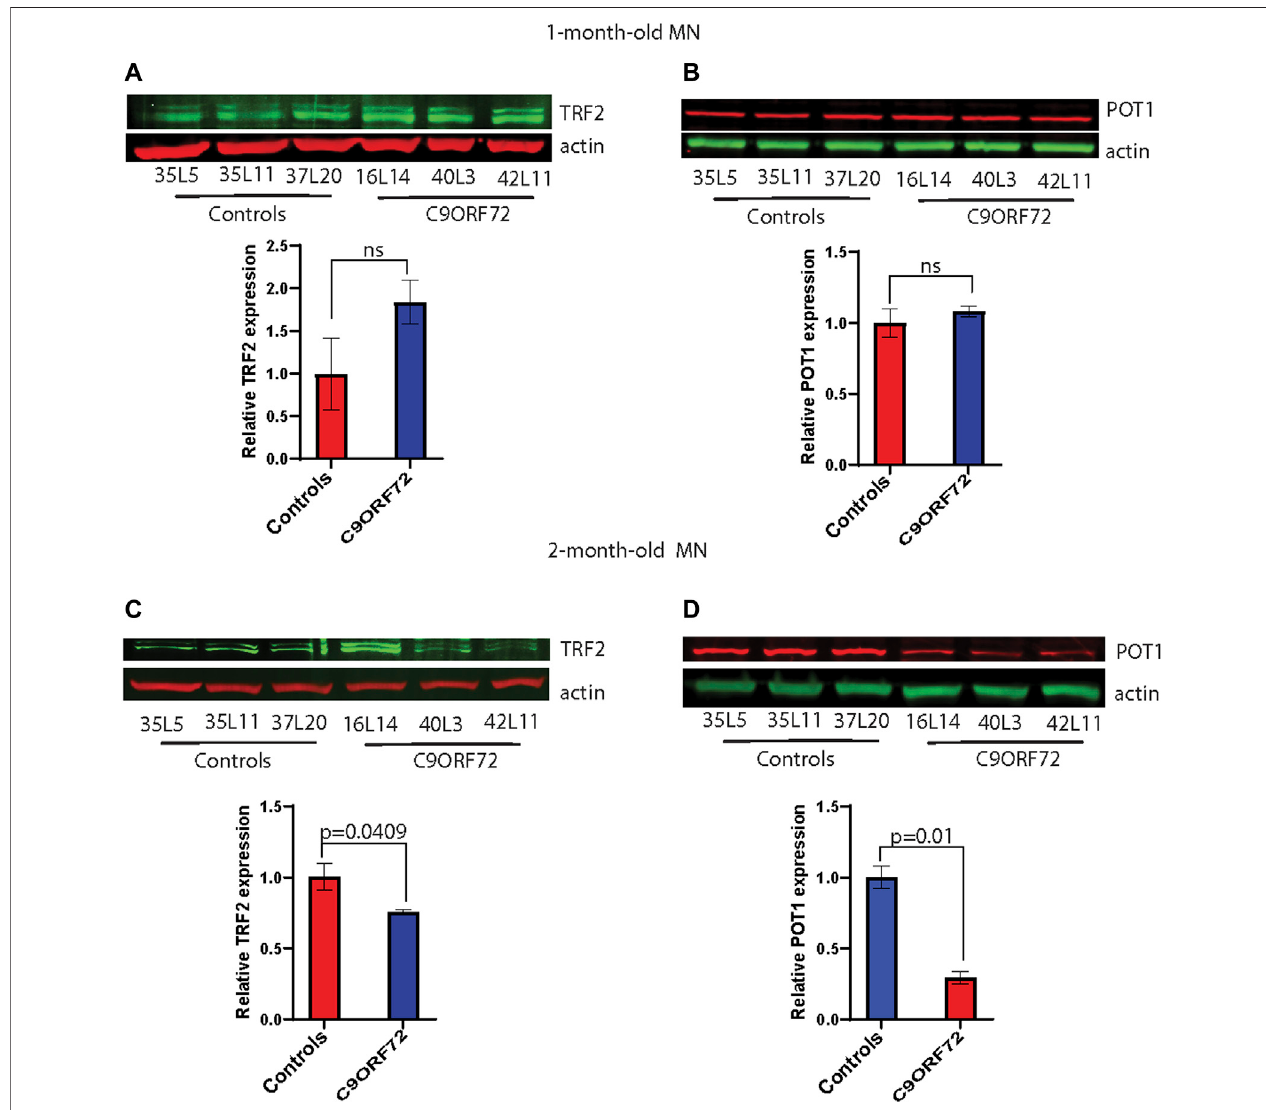
FIGURE 5 | Decreased protein levels of TRF2 and POT1 in 2 month-old-motor neurons. Western blot analyses of (A) TRF2, (B) POT1 in 1-month-old-motor neurons and (C) TRF2, (D) POT1 in 2 month-old-motor neurons from 3 controls and 3 C9ORF72 carriers. Two-tailed t -test with Welch ’ s correction was applied to western blot